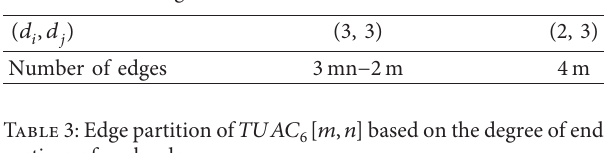
[ m, n ] based on the degree of end 6